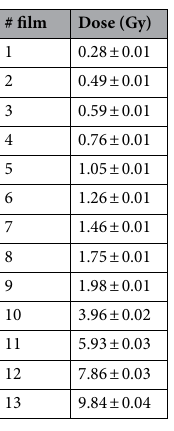
Table 1. Dose values of the irradiated